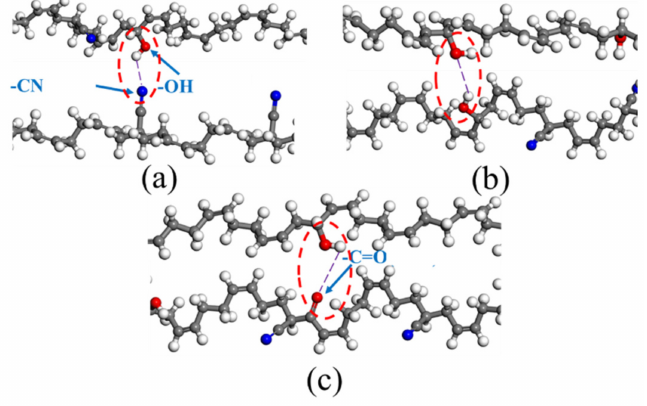
Figure 6. The types of H-bond in the aged rubber model: ( a ) H-bond (A) or O–H...N; ( b ) H-bond (B) or O–H...O (–OH); ( c ) H-bond (C) or O–H...O (–CO).